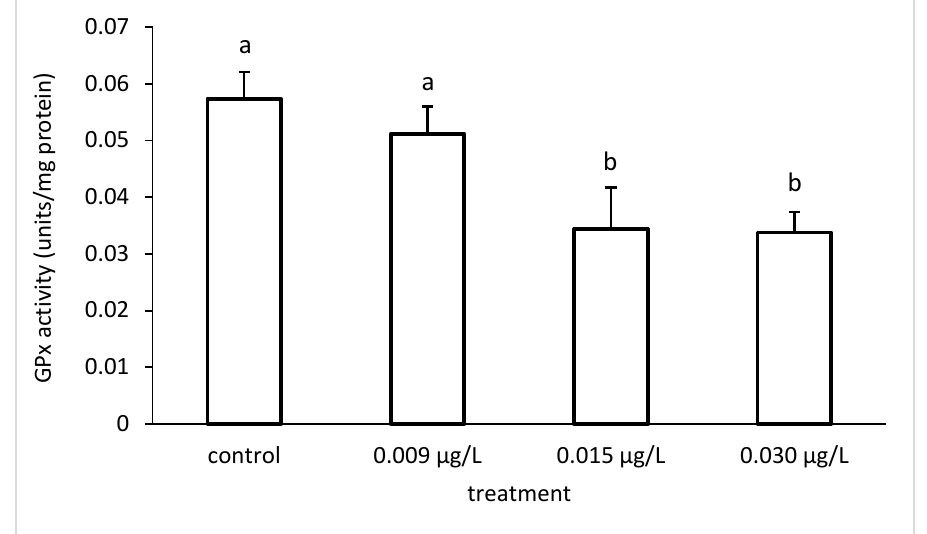
Figure 6. Glutathione peroxidase (GPx) activity in common carp liver under different CPF exposures. Bars represent means ± SD of the control and experimental groups. Different letters indicate significant differences among treatments ( p < 0.05).